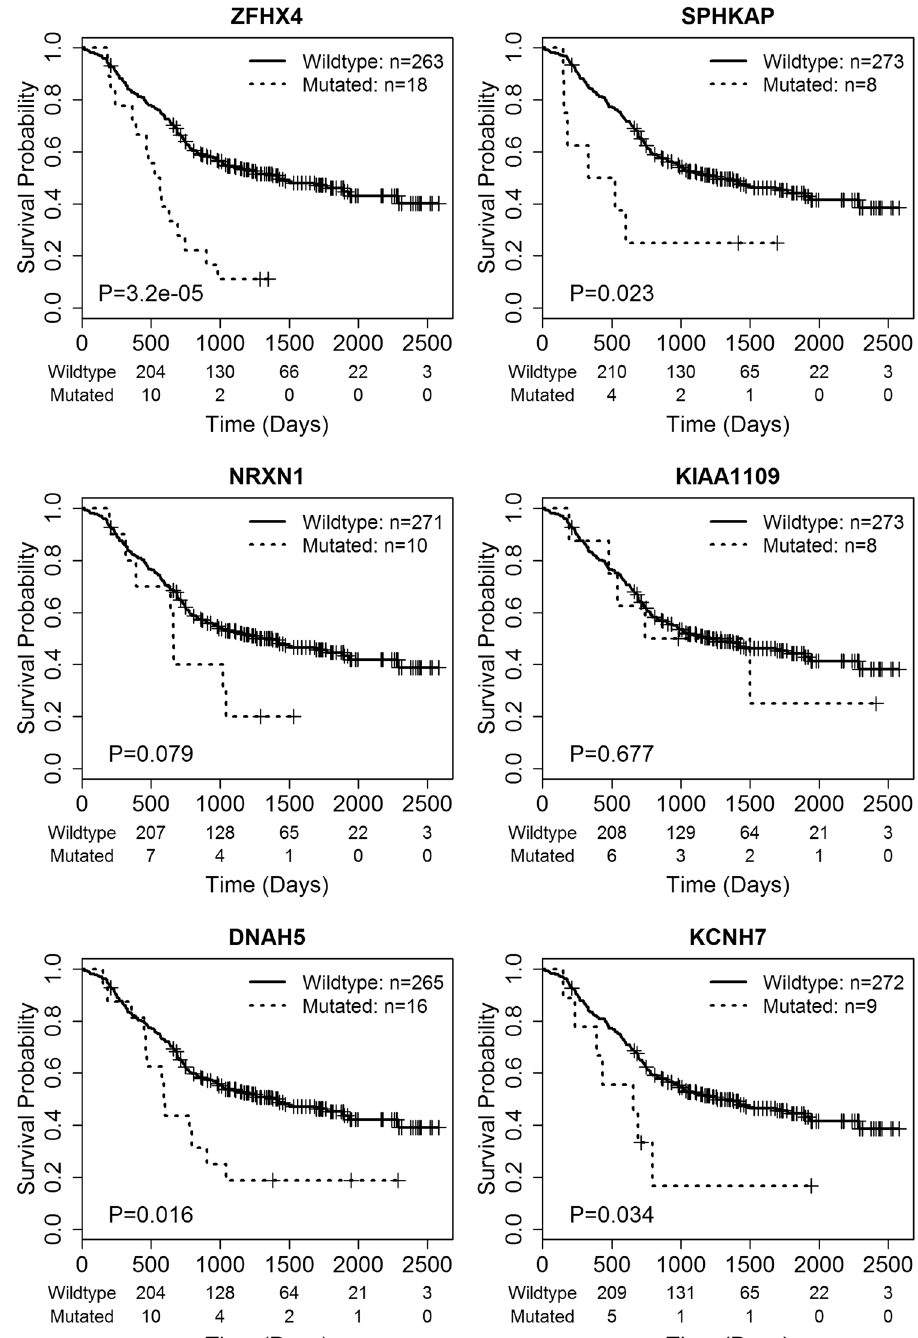
Figure 3. Survival analysis for missense mutations and frame-shift indels of frequently mutated genes. The overall survival rates of patients according to gene mutation status were shown. Only missenses mutations and frame shift indels were considered for each gene. Wildtype indicates a group of patients without a gene mutation. Mutated means that patients carry a gene mutation. P values were calculated by the log-rank